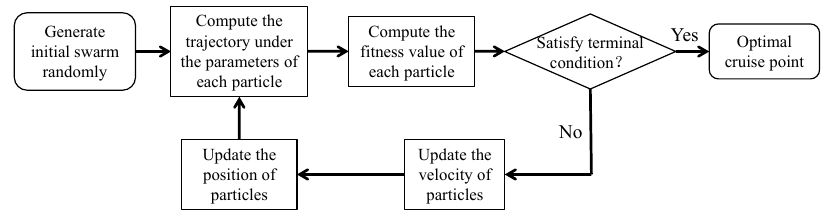
Figure 5. Optimization process.